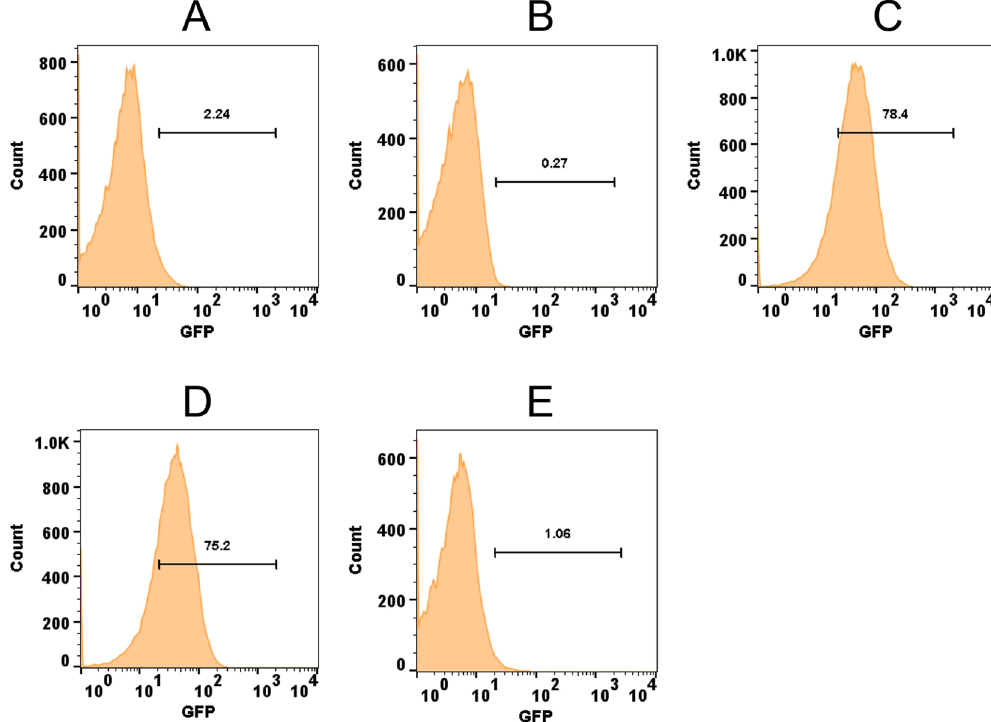
Figure 2. Examination of GFP expression in M . smegmatis strains by flow cytometry. Flow analysis was performed in BD FACSAriaII using excitation and emission wavelengths of 395 nm and 509 nm, respectively. ( A–E ) M . smegmatis strains. Wild-type ( A ), MSohRE ( B ), MSOHG1 ( C ), MSOHG2 ( D ) and MSOHG3 ( E ). MSohRE is a plasmid control. Strains MSOHG1, MSOHG2 and MSOHG3 carry pohrR - gfpuv , pohr - gfpuv